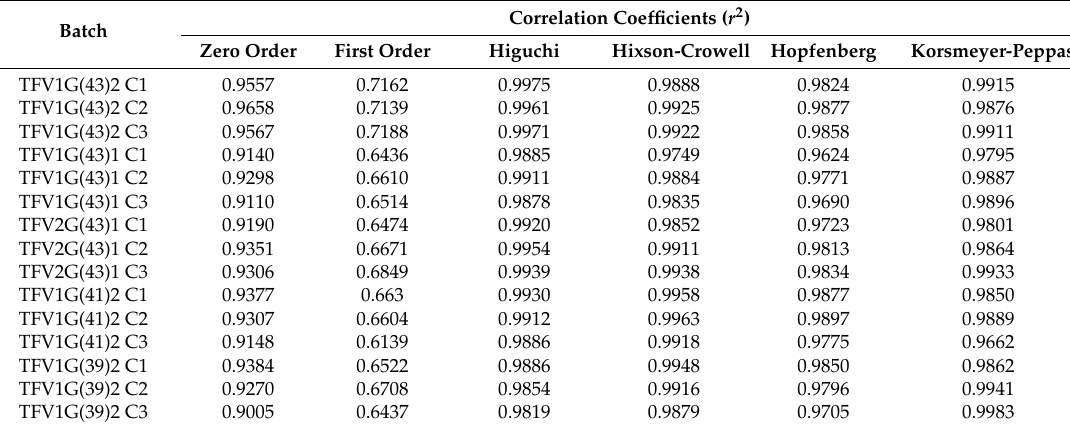
Table 4. Correlation coefficients obtained when experimental data are fitted to different mathematical